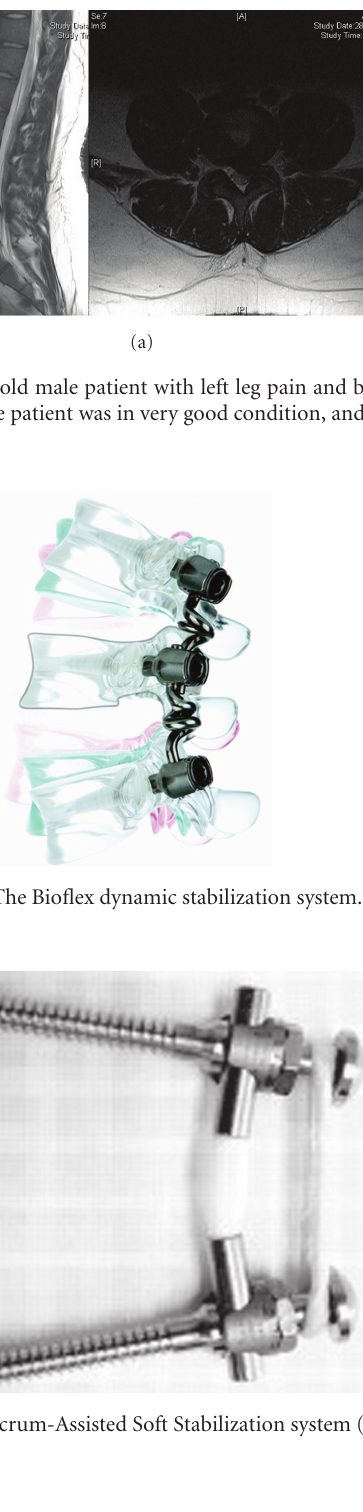
zone” (NZ) in the development of spinal instability [3]. The NZ is a region of intervertebral motion around the neutral posture where little resistance is o ff ered by the passive spinal column. It is believed that the NZ increases during disc degeneration and injury, resulting in greater instability and pain. The Stabilimax NZ system was developed to reduce the